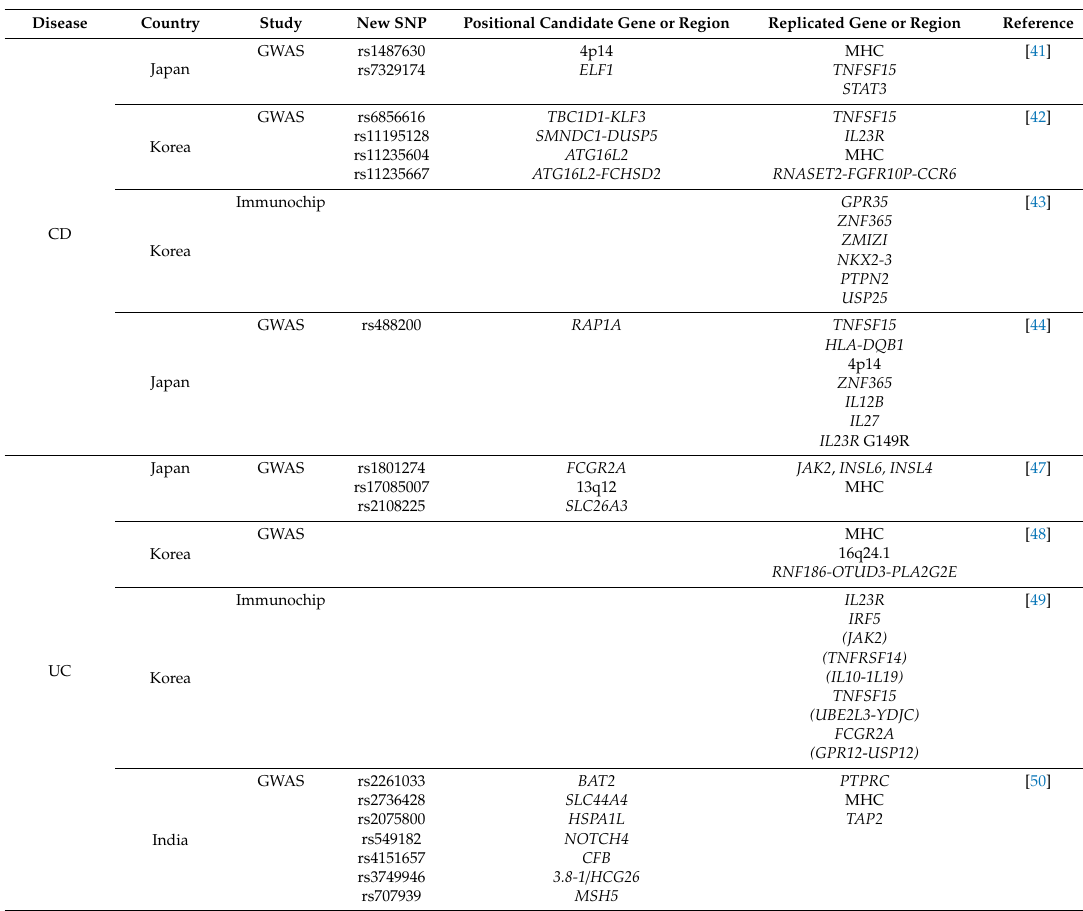
Table 1. Genome-wide association and Immunochip studies on inflammatory bowel disease susceptibility genes in Asia [46]. Disease Country Study New SNP Positional Candidate Gene or Region Replicated Gene or Region